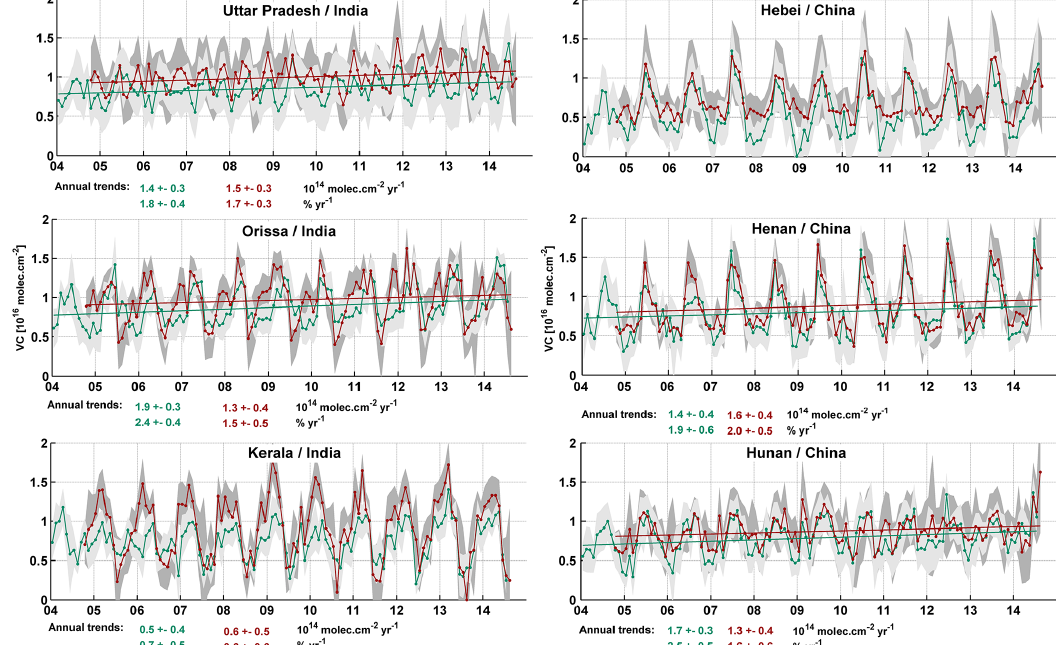
Figure 14. Monthly averaged H 2 CO vertical columns as observed from satellite instruments in India and China. Mid-morning columns (in green) consist of SCIAMACHY (2003–2011) and GOME-2A (2007–2013) and GOME-2B (2013– ) measurements. If statistically significant, results of the trend analysis are displayed (De Smedt et al., 2010).